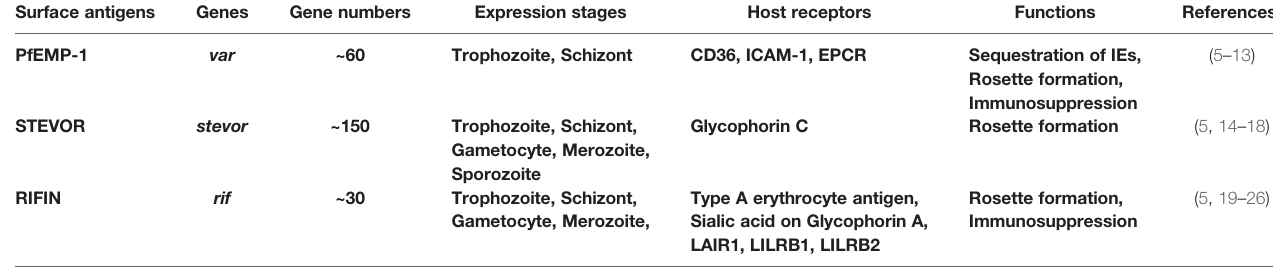
TABLE 1 | Summary of P. falciparum-infected surface antigens in this Review. Surface